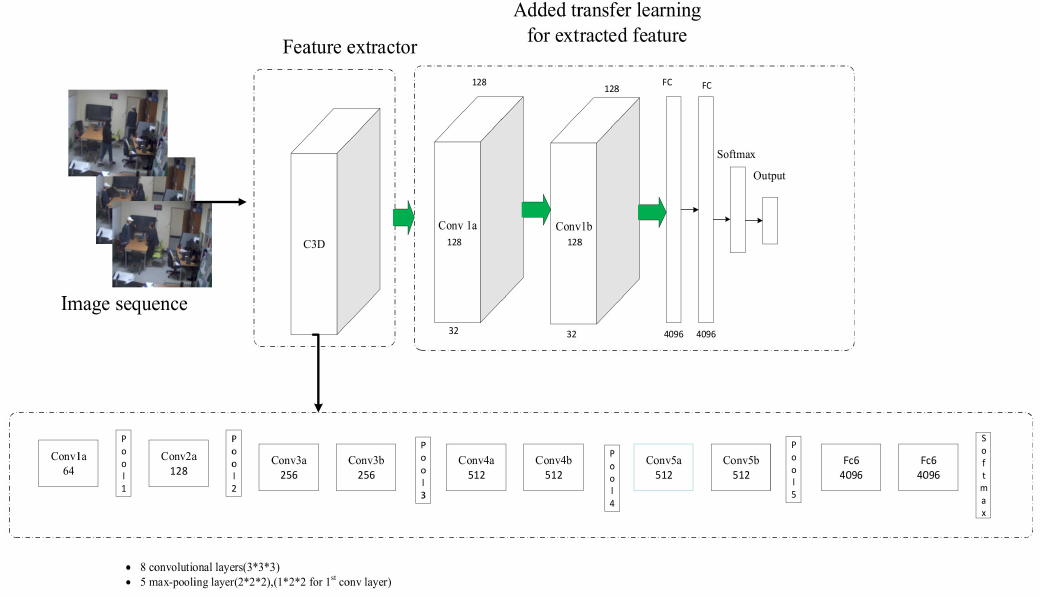
Figure 3. Proposed transfer learning model for lab-action data combined with Convolutional 3 Dimensional (C3D) and lab-action image